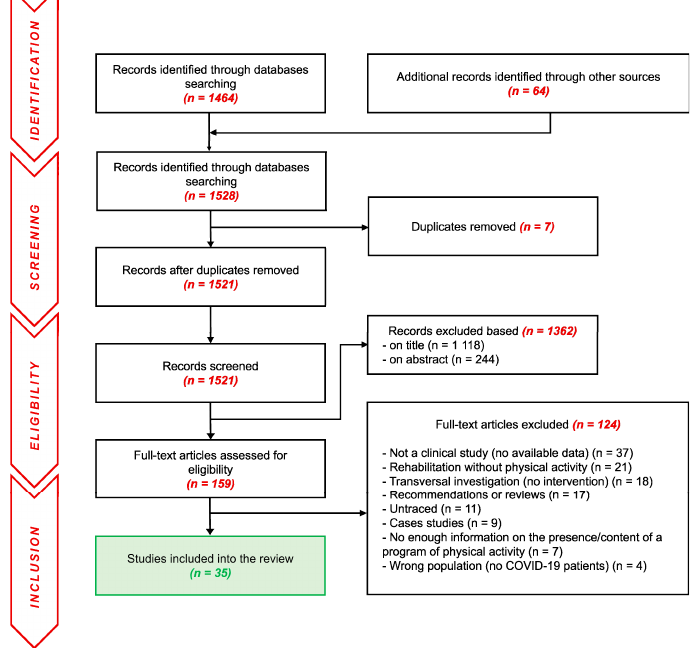
Figure 1. Flow diagram of the identification, screening, eligibility, and inclusion of the studies in the systematic review.